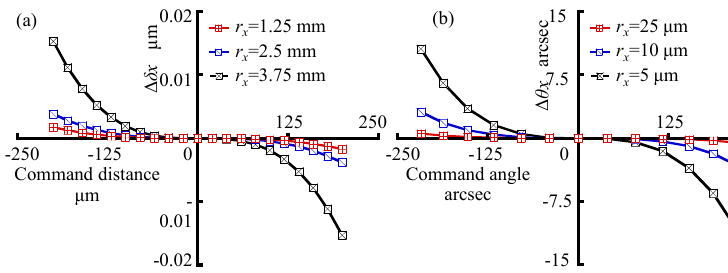
Figure 2. Effect of r x on ( a ) Δ δ x and ( b ) Δ θ x .